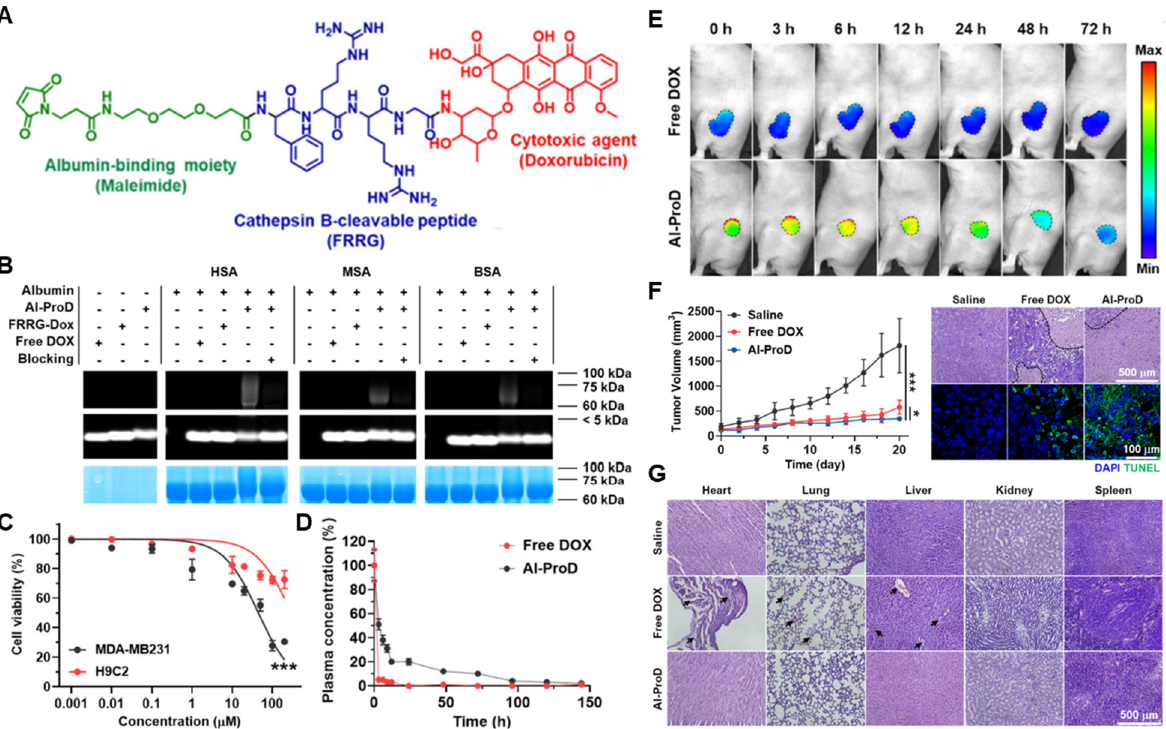
Figure 3. Cathepsin B-specific albumin-binding prodrug. ( A ) Albumin-binding maleimide moiety is conjugated with doxorubicin through cathepsin B-specific cleavable peptide FRRG. ( B ) The resulting Al-ProD is efficiently bound to three types of albumin (HSA, MSA and BSA). ( C ) Al-ProD induces a potent cytotoxicity in MDA-MB231 breast cancer cells, whereas cytotoxicity is greatly minimized in H9C2 cardiomyocytes. ( D ) Al-ProD shows extended half-life in vivo via binding with endogenous albumins compared to free DOX. ( E ) With extended half-life, Al-ProD efficiently accumulates within tumor tissues. ( F ) Al-ProD significantly delays tumor progression by inducing a potent apoptosis in tumor tissues. ( G ) Al-ProD greatly minimizes the systemic toxicity by selective drug release in tumor tissues. * p < 0.05 and *** p < 0.001. Reproduced with permission from [216]. Copyright 2022, Cho, et